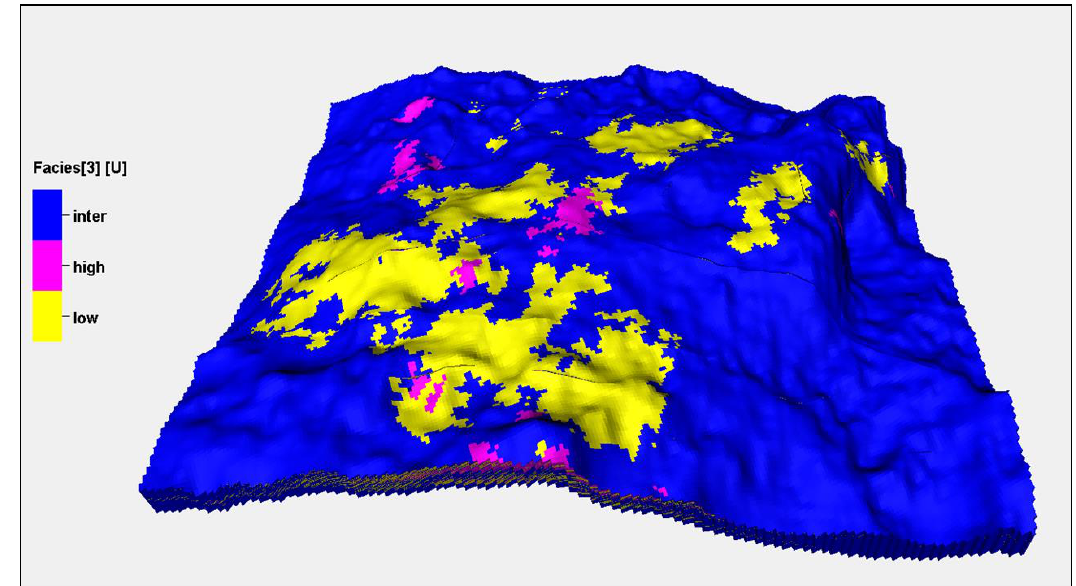
Figure 13. Distribution of lithofacies in B-P gas field.